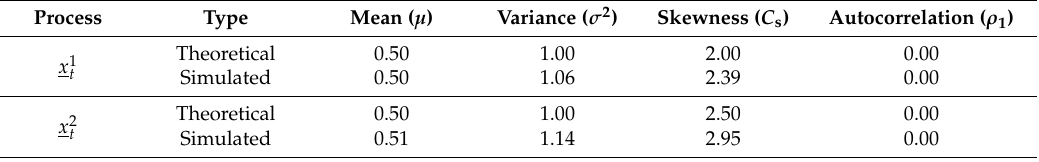
Figure A1. Scenario-based (see Table 1 of the main manuscript; Section 2.2—“The envelope behavior in the classical univariate AR(1) model”) comparison of synthetic (using the an AR(1) with P III white noise) and theoretical autocorrelation function (ACF). The labels of each plot resemble the corresponding scenarios of the aforementioned table (see also Table A1). Table A2. Summary of theoretical and simulated statistics for the first, zero-autocorrelated, bivariate AR(1) process with P III white noise, employed in Section 2.3—“From the univariate to the multivariate AR(1) model” of the main manuscript.